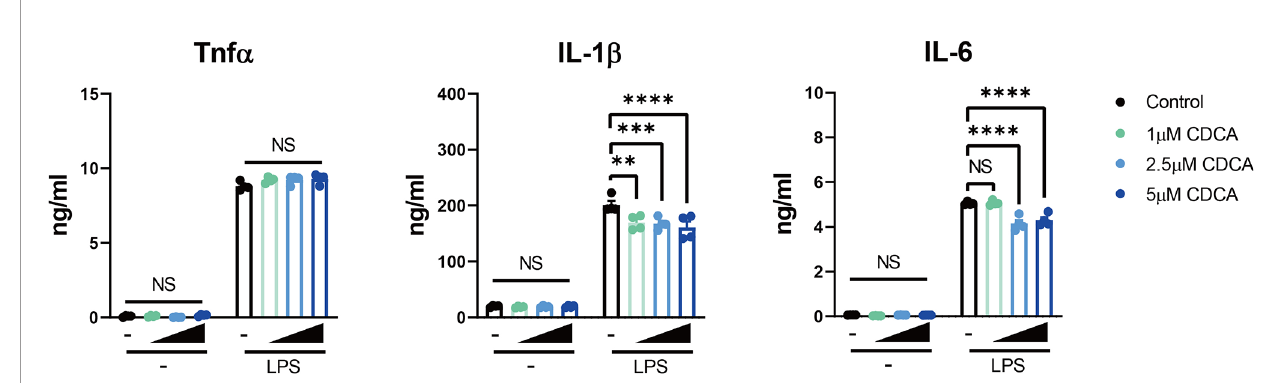
FIGURE 3 | Pathological Level of CDCA Decreases IL-6 Expression in Macrophages. RAW 264.7 macrophages were incubated with or without different concentrations of CDCA for 24h, and then stimulated with or without 100ng/ml LPS. TNF a , IL-1 b and IL-6 levels in the supernatant from 24-hr cultures are shown.